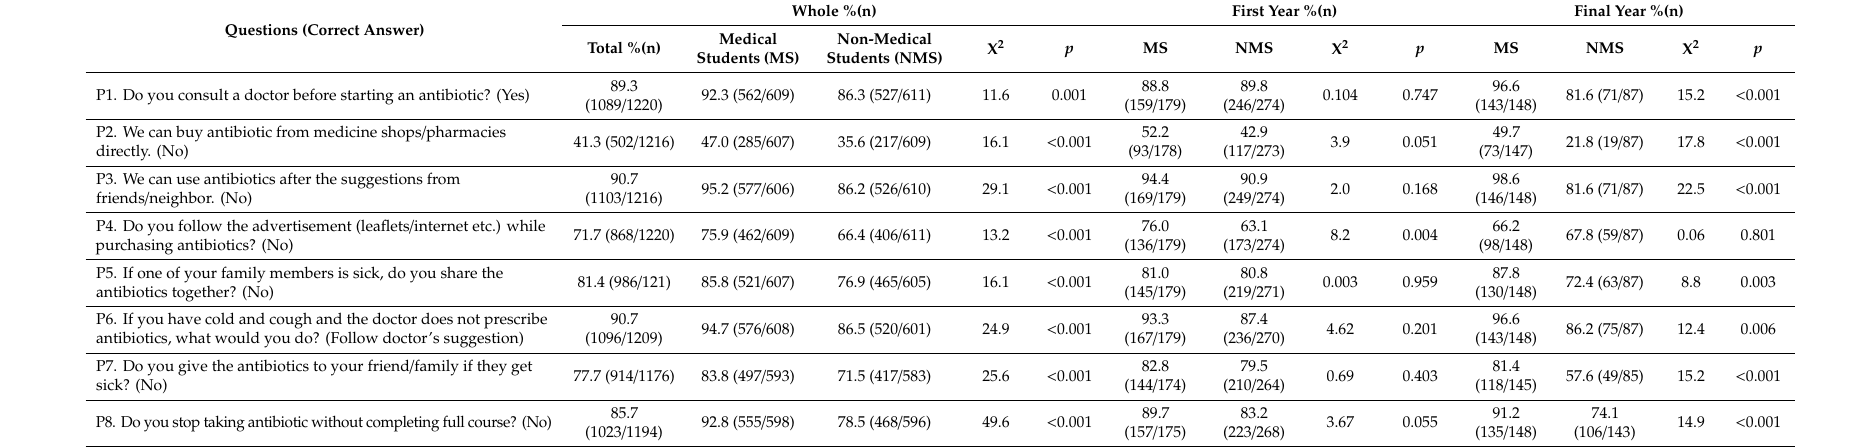
Table 4. Priority items of students’ practice on antibiotic